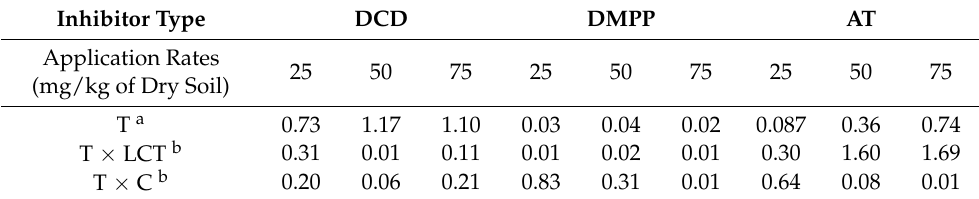
Table 2. F-values from the ANOVA of the inhibitory